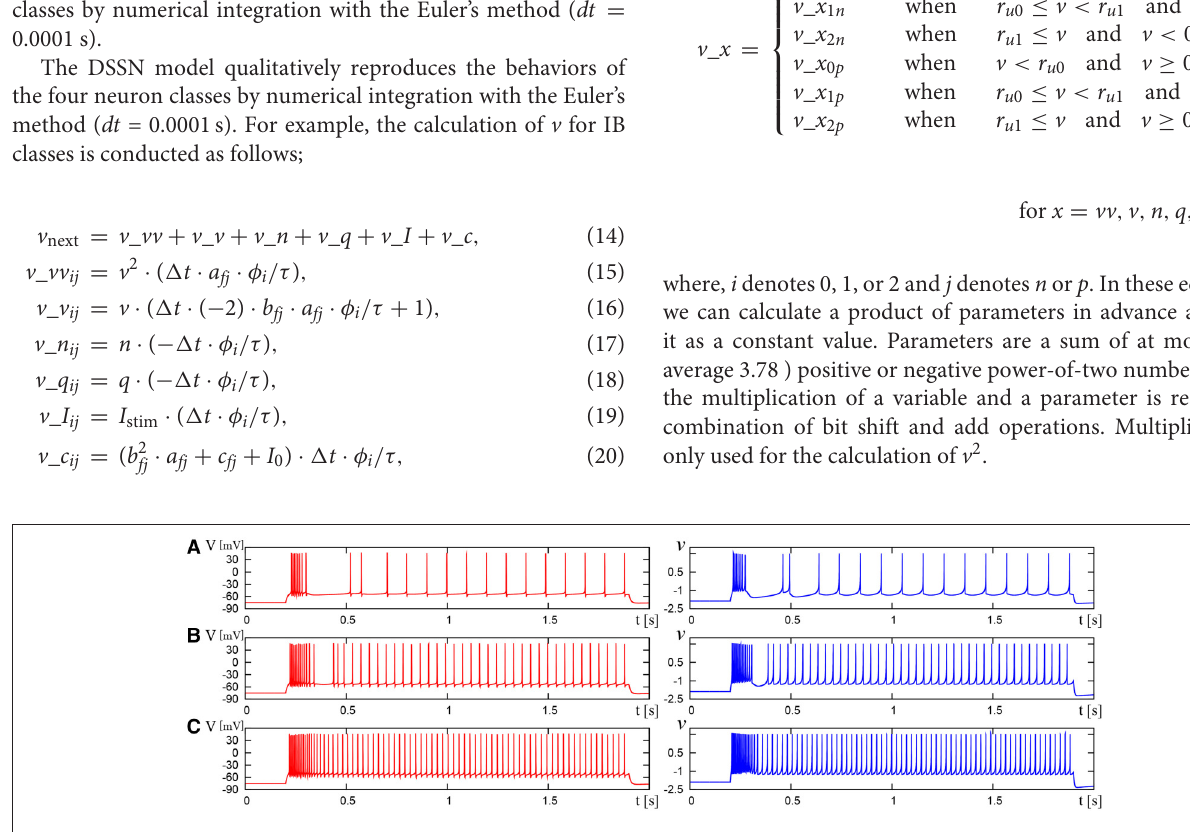
FIGURE 11 | Waveforms of Pospischils’ model and DSSN model which correspond to a neuron in the IB class. The Pospischils’ model (left) generates periodic spikes in response to a step input rising at t = 0.2 where I stim is (A) 2.38, (B) 2.6645, (C) 3.0495 nA. The DSSN’ model (right) generates periodic spikes in response to a step input rising at t = 0.2 where I stim is (A) 0.89, (B) 1.42, (C) 1.81.